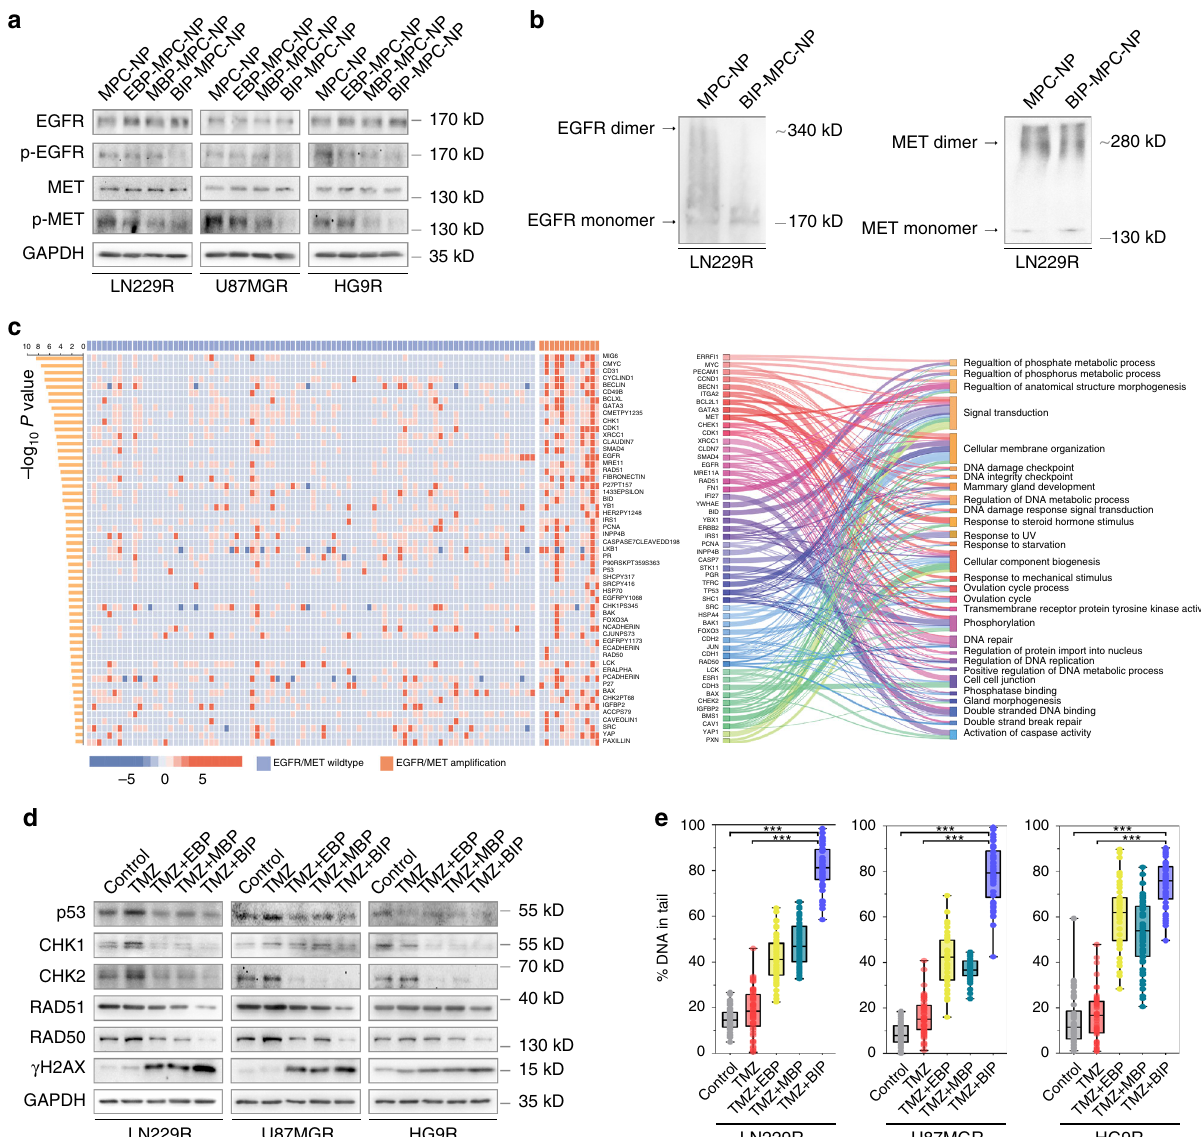
Fig. 3 BIP-MPC-NP inhibits DNA damage repair via the mitigation of EGFR and MET signaling pathways. a The EGFR, p-EGFR, MET and p-MET expression in TMZ-resistant glioma cells treated with different nanoinhibitors. b The levels of EGFR and MET dimers in TMZ-resistant glioma cells treated with BIP-MPC-NP. c The heatmap displayed the differential expressed proteins between GBM patients with low EGFR and MET copy numbers group and with high EGFR and MET copy numbers group. The Sankey diagram displayed the Gene Ontology of the differentially expressed proteins. d The inhibition of DNA damage repair modules expression and the increase of γ H2AX expression with the treatments of TMZ and different nanoinhibitors in LN229R, U87MGR and HG9R. e The boxplots showing the statistics of comet assay of TMZ-resistant glioma cells with TMZ and different nanoinhibitors ( n = 50). In the box plots, bounds of the box spans from 25 to 75% percentile, center line represents median, and whiskers visualize minimum and maximum of the data points. P value is determined by Student ’ s t -test. Signi fi cant results are presented as *** P <